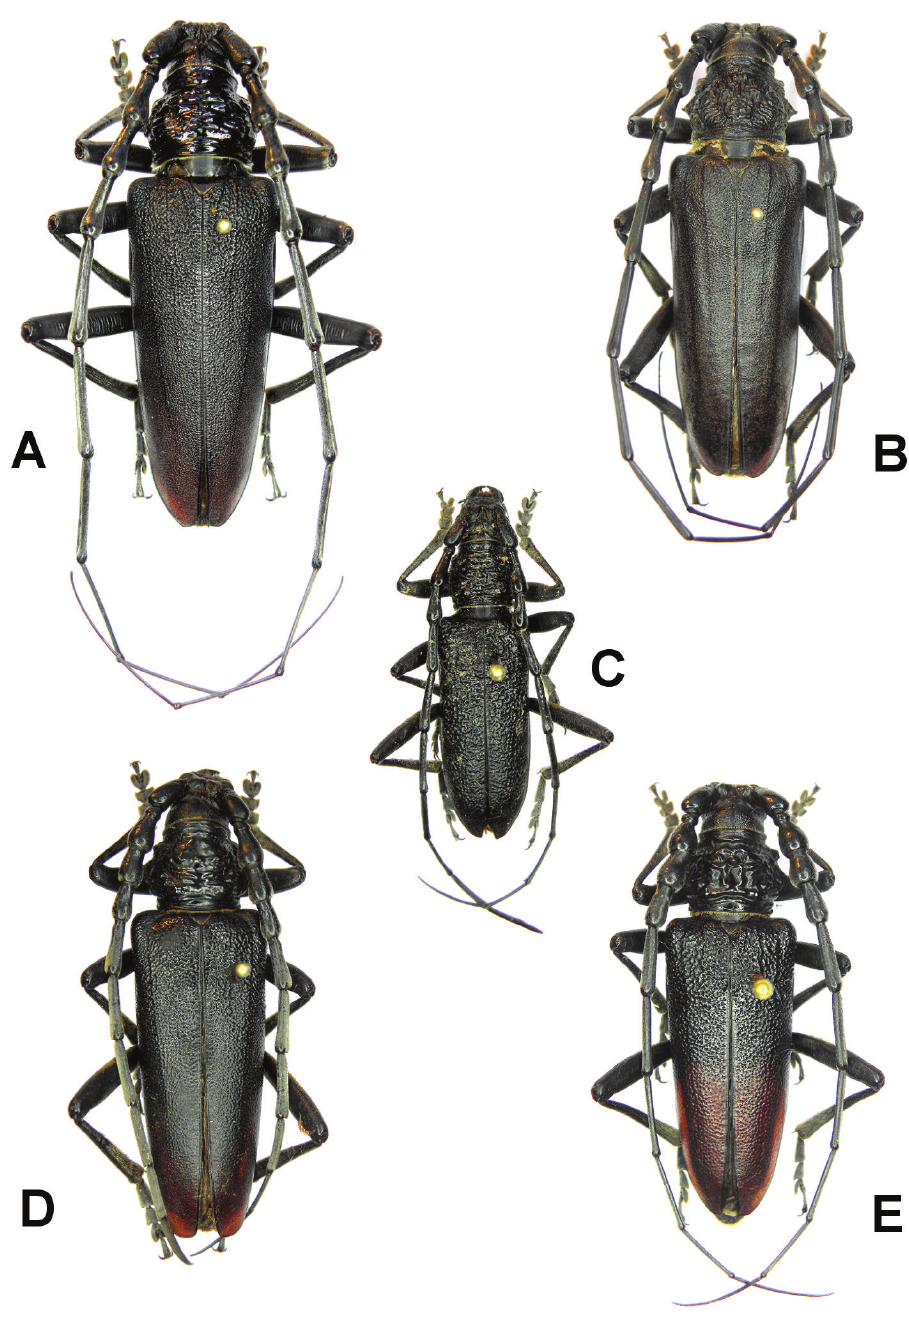
Figure 1. The most widespread species of Cerambyx in Europe: A C. cerdo B C. welensii C C. scopolii D C. miles E C. nodulosus (photo by Pierpaolo